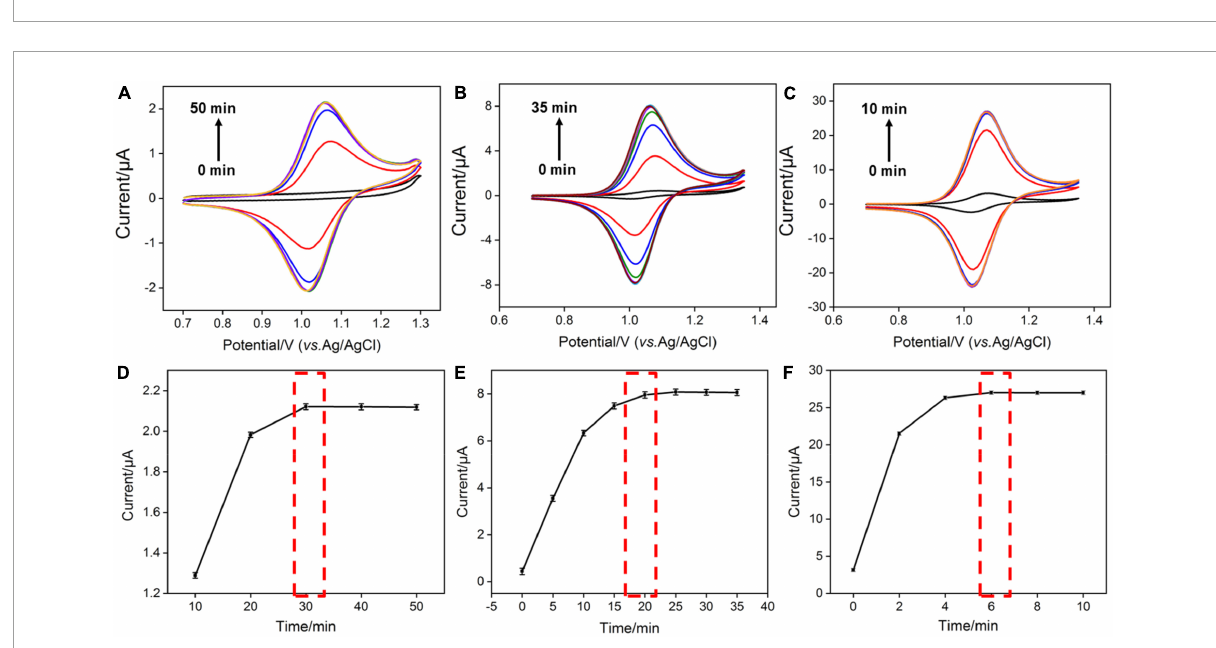
FIGURE4 (A–C) CV curves obtained at the VMSF/ITO electrode with different accumulation time in 0.1 M PBS solution (pH 7.0) containing various concentrations of Ru(bpy) 32 + . The scan rate was 100 mV/s. (D–F) The relationship between anodic peak currents and accumulation time.